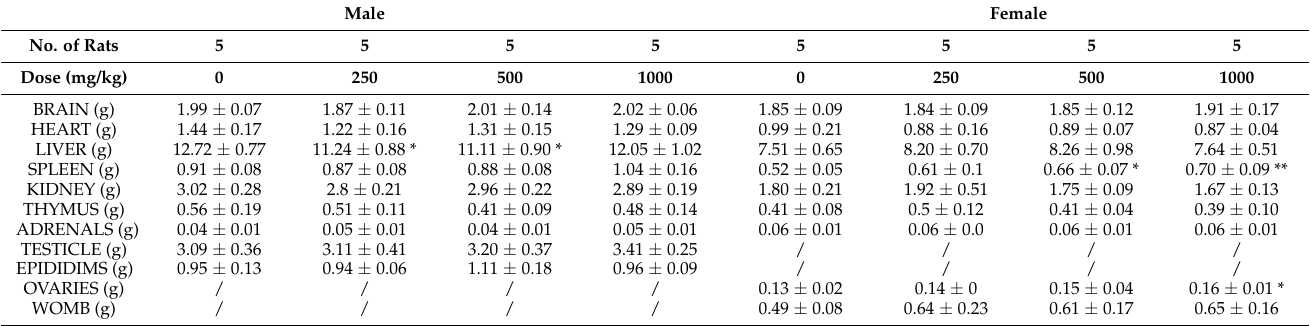
Table 4. Absolute organ weight of male and female rats fed with 0, 250, 500, and 1000 mg/kg b.w./day curcumol for 28 days. Values are mean ± SD for five rats/sex/group.